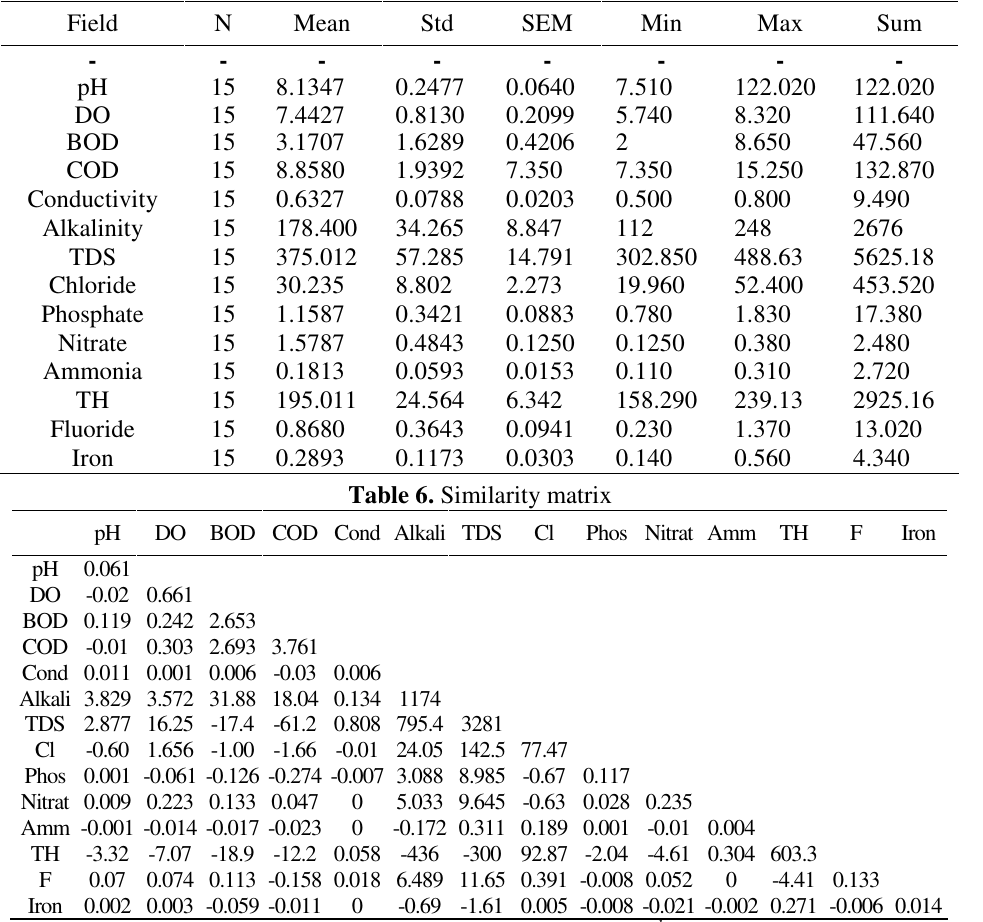
Table 5. Descriptive statistics (At post- monsoon )